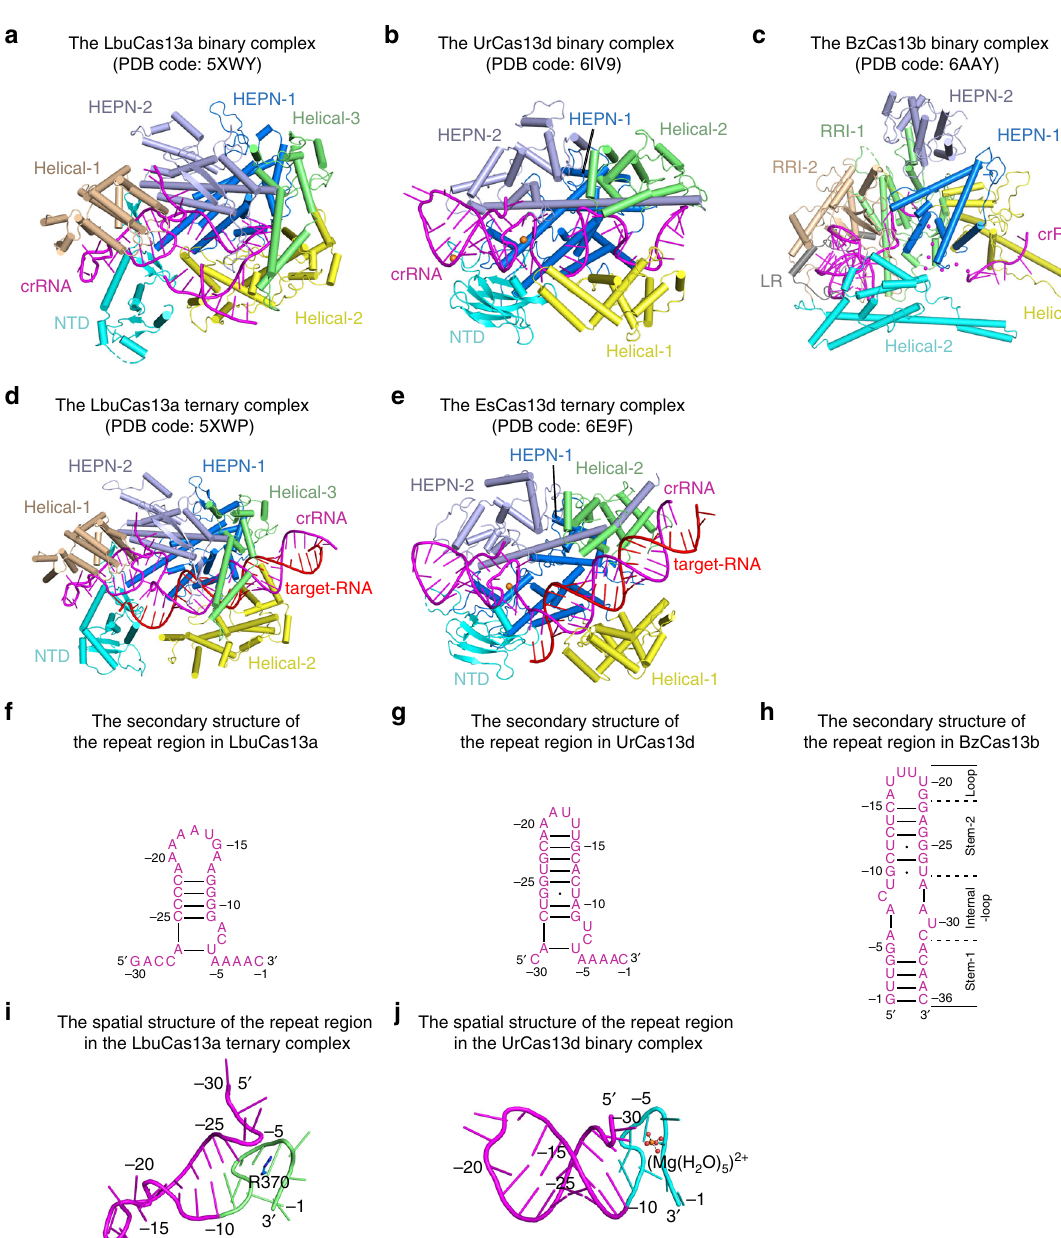
Fig. 7 Comparison of Cas13a, Cas13b, and Cas13d. a Domain architectures of the LbuCas13a ( Leptotrichia buccalis Cas13a) binary complex (PDB code: 5XWY). b Domain architectures of the UrCas13d binary complex (PDB code: 6IV9). c Domain architectures of the BzCas13b binary complex (PDB code: 6AAY). d Domain architectures of the LbuCas13a ternary complex (PDB code: 5XWP). e Domain architectures of the EsCas13d ( Eubacterium siraeum Cas13d) ternary complex (PDB code: 6E9F). f – h Schematic representations of the secondary structures of the crRNA repeat regions in LbuCas13a, UrCas13d and BzCas13b, respectively. Bars between nucleotide pairs represent Watson-Crick base pairs and dots represent wobble G-U base pairs. i The structure of the crRNA repeat region in the LbuCas13a ternary complex. The nucleotides G(-9)-C(-1) in the repeat region are colored in green. Residue R370 of LbuCas13a is shown and labeled. j The structure of the crRNA repeat region in the UrCas13d binary complex. The nucleotides G(-9)-C(-1) in the repeat region are colored in cyan. The penta-hydrated Mg 2 + is shown and tolerance between the crRNA spacer region and target RNA. Our synthesized (Supplementary Table 3) and cloned between Nde I and Xho I sites of fi ndings provide valuable information for rational engineering the pCDFDuet-1 vector. To acquire the binary complex assembled in vivo, vectors encoding the that would aid in developing the CRISPR-Cas13d system into an UrCas13d R288A/R823A mutant and CRISPR template were co-transformed into ef fi cient tool for research, therapeutics and biotechnology. E.coli Rosetta (DE3) cells (Novagen). The cells were then grown at 37 °C for 3h until the cell concentration reached OD 600 of approximately 0.6, which was followed by induction with 0.2 mM IPTG at 18°C for 12 h. The cells were Methods harvested and lysed in buffer A (25 mM Tris-HCl (pH 7.5), 500 mM NaCl, 5mM β -mercaptoethanol, 1 mM phenylmethanesulfonyl fl uoride (PMSF)). The lysate Puri fi cation of the UrCas13d binary complex assembled in vivo . The full-length was centrifuged and the supernatant was loaded onto a Ni-NTA Super fl ow gene encoding UrCas13d was synthesized (Supplementary Table 2) and inserted (QIAGEN) column. The nickel column was washed with buffer A containing 10 between Nde I and Xho I sites of the pET-30b vector. CRISPR template was